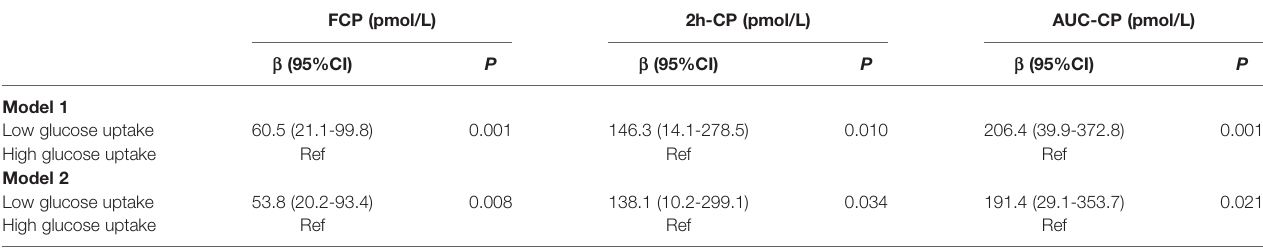
FCP, Fasting C-peptide; 2h-CP, 2 hours postprandial C-peptide; AUC-CP, Area under curve of C-peptide; Ref, reference. Model 1: unadjusted. Model 2: adjusted for course of disease, C-peptide at onset, and hemoglobin